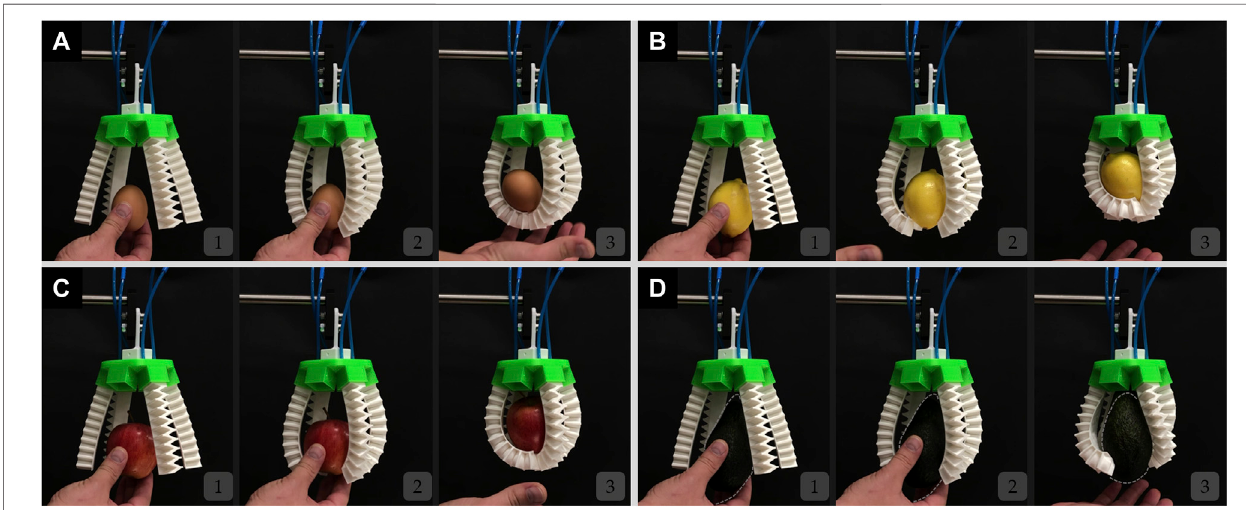
FIGURE 11 | The soft modular gripper in a four- fi nger con fi guration without the mechanical metamaterial attempts tobut fails to grasp (A) an egg, (B) a lemon, (C) an apple, (D) and fails to grasp stably an avocado.